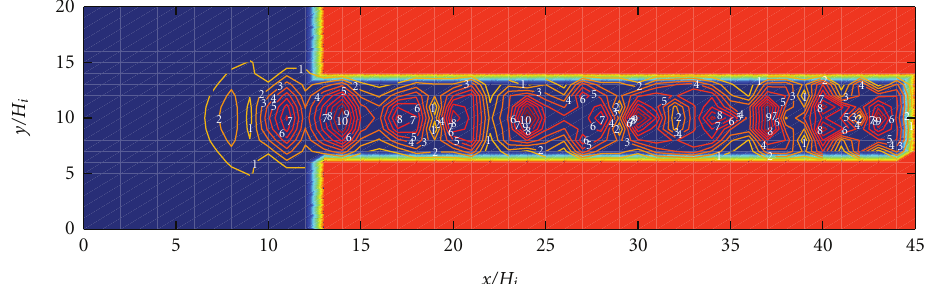
Figure 8: Relative wave height distribution into the small harbour.